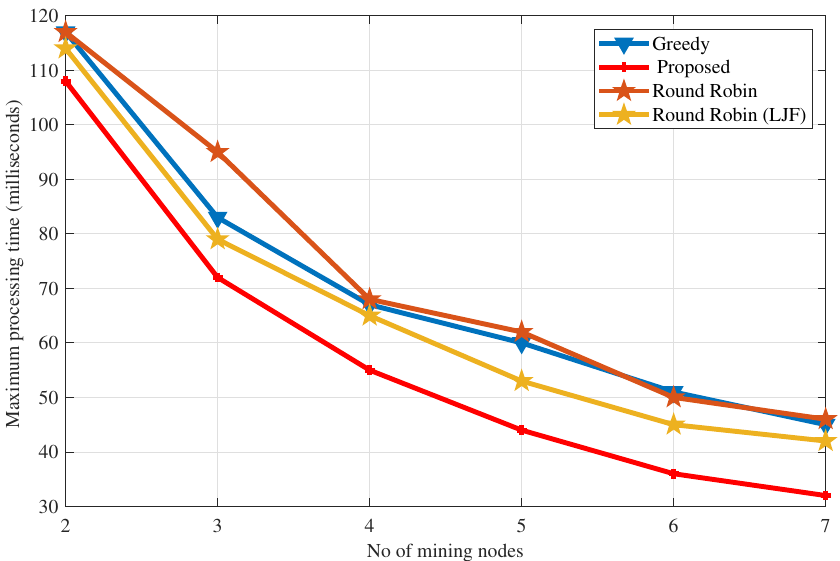
Figure 5. Nonce computing against varying number of mining